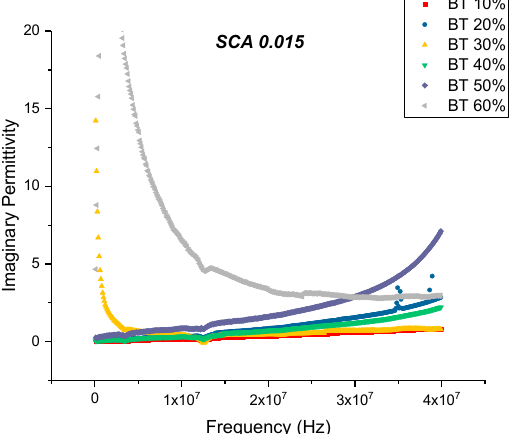
Figure 10. The dielectric loss of the BaTiO 3 -epoxy composite that were fabricated using BaTiO 3 nanoparticles which were surface modified using 0.015 SCA is plotted as a function of frequency where the volume fraction of BaTiO 3 is varied from 0.1 to 0.6. The maximum value is 1.60 for BaTiO 3 at 0.6 volume fraction.